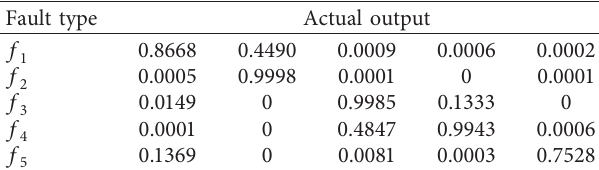
Table 6: LDWPSO-BP neural network diagnosis results. Fault type